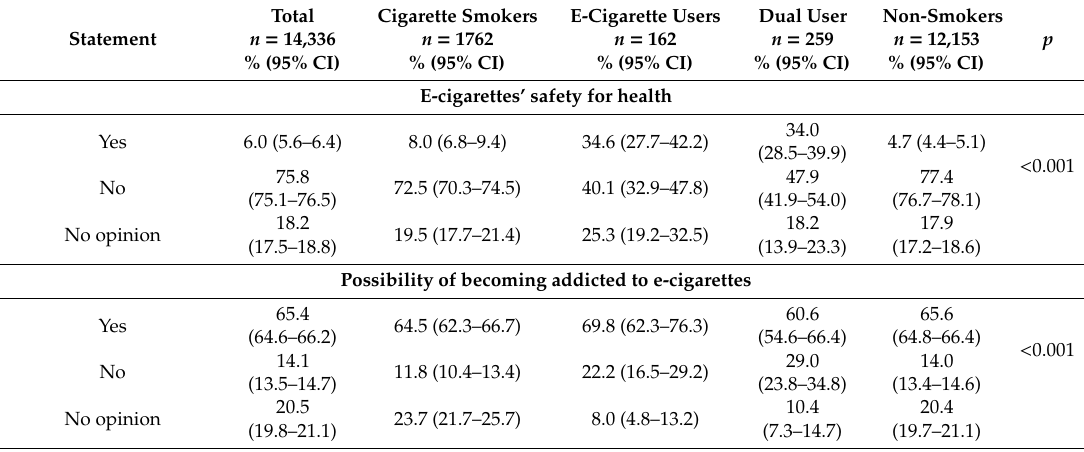
Table 4. Perception of e-cigarette using among